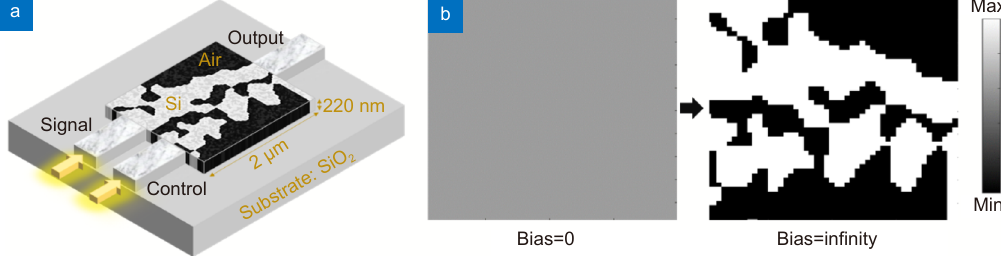
Fig. 1 | Design optimization process of the all-optical switch. ( a ) General configuration of the all-optical switch. ( b ) The initialization and dis- crete optimization permittivity distribution in the x - y two-dimensional cross-section, where bias=0 and